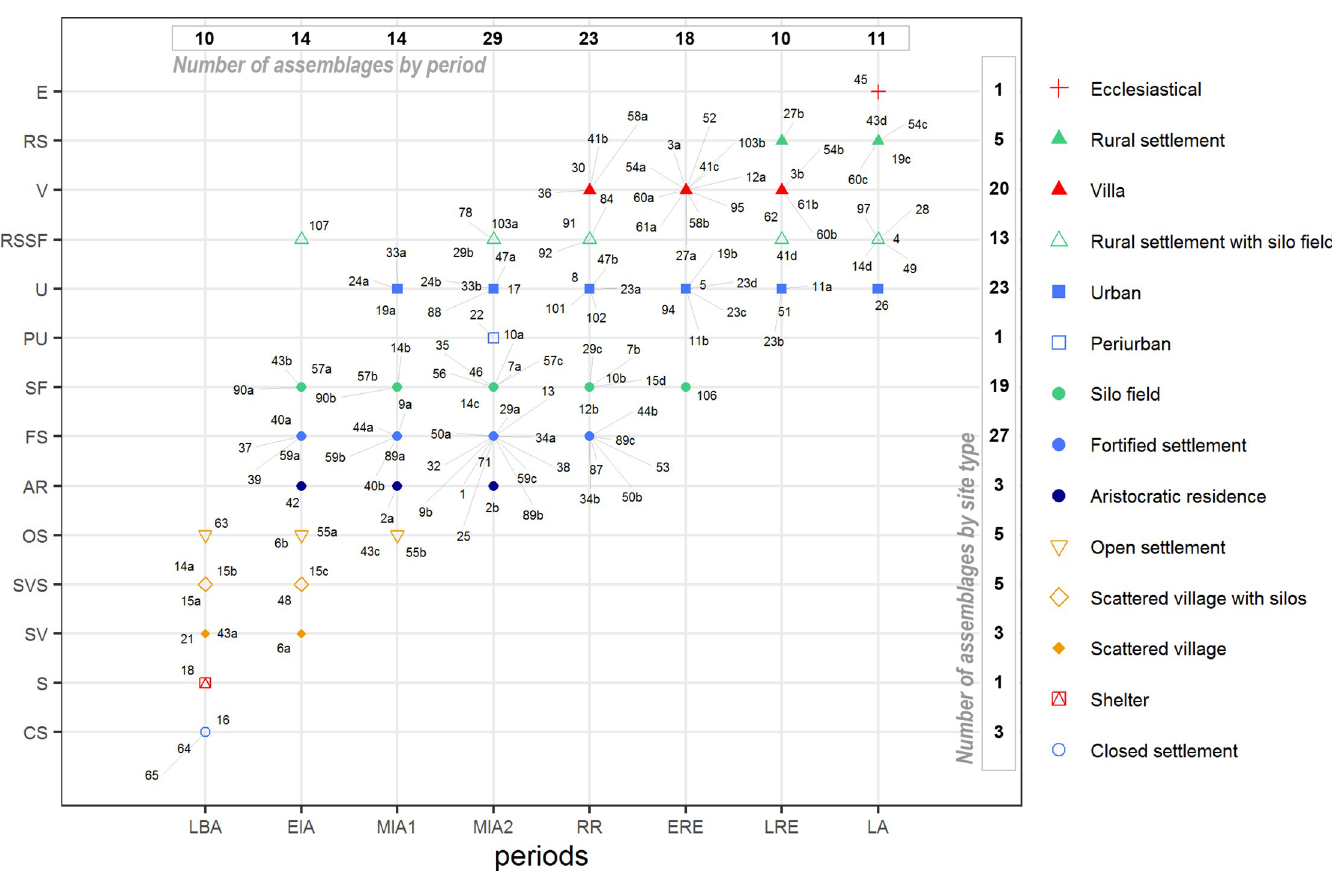
Fig 2. Chrono-typology seriation of the 127 studied assemblages from Late Bronze Age to Late Antiquity. (LBA: Late Bronze Age, EIA: Early Iron Age, MIA1: Middle Iron Age 1, MIA2: Middle Iron Age 2, RR: Roman Republic, ERE: Early Roman Empire, LRE: Late Roman Empire, LA: Late Antiquity). The x-axis represents the assemblages by periods and the y-axis represented the type of sites. List of assemblage numbers: 1. Esquerda; 2a. Alorda Park 2a; 2b. Alorda Park 2b; 3a. Antigons_waste dump; 3b. Antigons_ Nymphaeum ; 4. Aubert; 5. Baetulo; 6a. Barranc de G à fols_1; 6b. Barranc de G à fols_2; 7a. Bosc del Congost; 7b. Bosc del Congost; 8. Burriac; 9a. Ca n’Oliver 1; 9b. Ca n’Oliver 2_3; 10a. Can Bartomeu; 10b. Can Bartomeu; 11a. Can Cruzate; 11b. Can Cruzate; 12a. Can Feu; 12b. Can Feu; 13. Turo´ de la Rovira; 14a. Can Gambu´s 3; 14b. Can Gambu´s 3; 14c. Can Gambu´s 1; 14d. Can Gambu´s 1; 15a. Can Roqueta CRV; 15b. Can Roqueta TR; 15c. Can Roqueta DIASA; 15d. Can Roqueta TR; 16. Carretel à ; 17. Ciutadella de Roses; 18. Cova Punta Farisa; 19a. Empu´ries; 19b. Empu´ries; 19c. Empu´ries; 21. Fonollera; 22. Gou Batlle; 23a. Ilerda; 23c. Ilerda1_Carrer Magdalena 47; 23d. Ilerda2_Carrer Bafart 46; 24a.I lla d’en Reixach 2_3; 24b. Illa d’en Reixach 4_5_6; 25. Puig Castellar; 26.